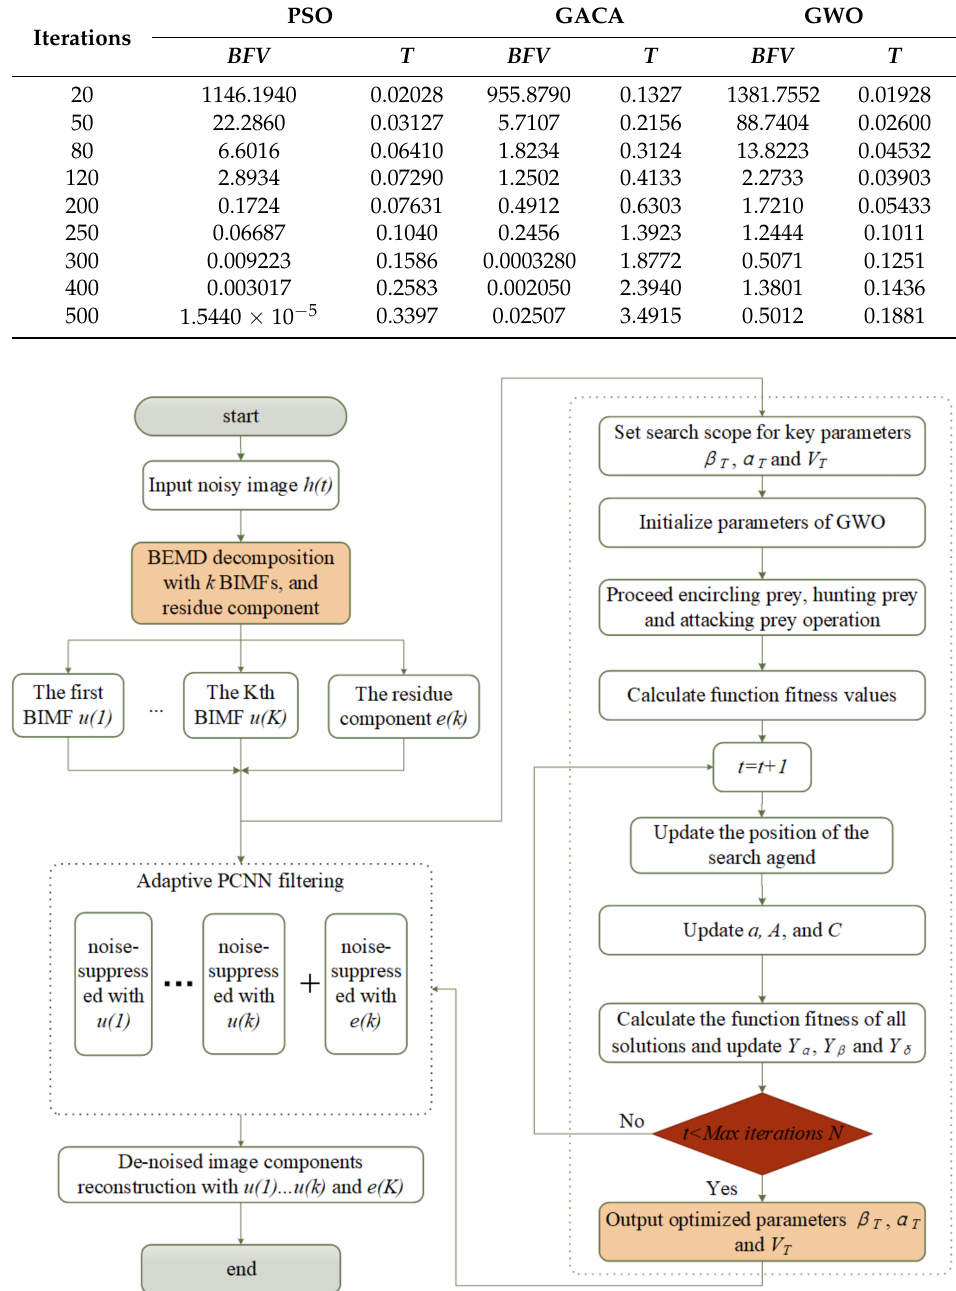
Table 1. The calculated function fitness values through different iterations and required run time for optimization by the PSO, GACA, and GWO.